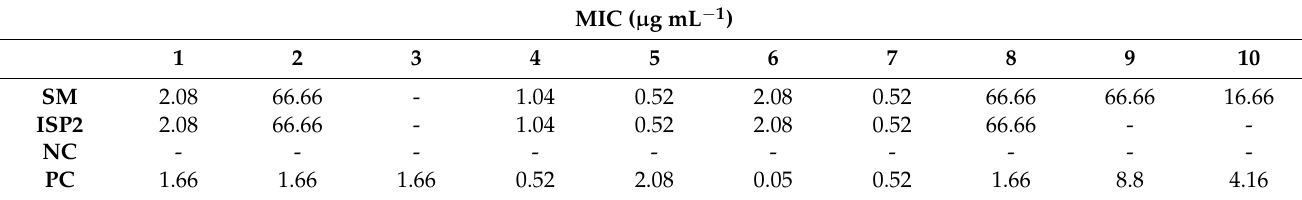
Table 1. Antimicrobial activity of strain CG3 against human pathogenic